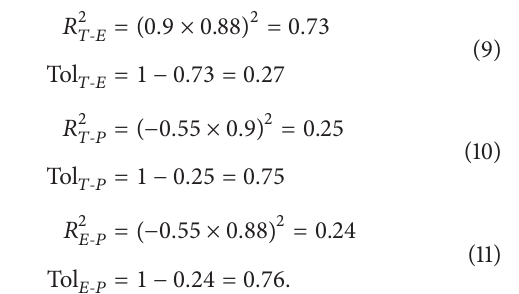
As a matter of experience, a threshold value of 0.1 for Tol is often adopted [51]. If Tol value exceeds 0.1, it means there is no collinearity problem between the two factors involved.